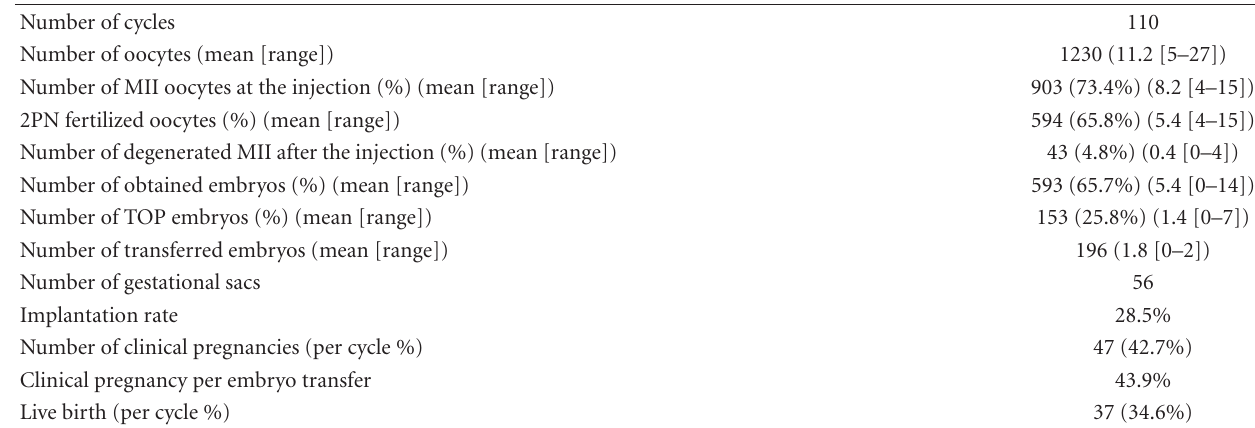
Table 1: ICSI cycle characteristics and outcomes.